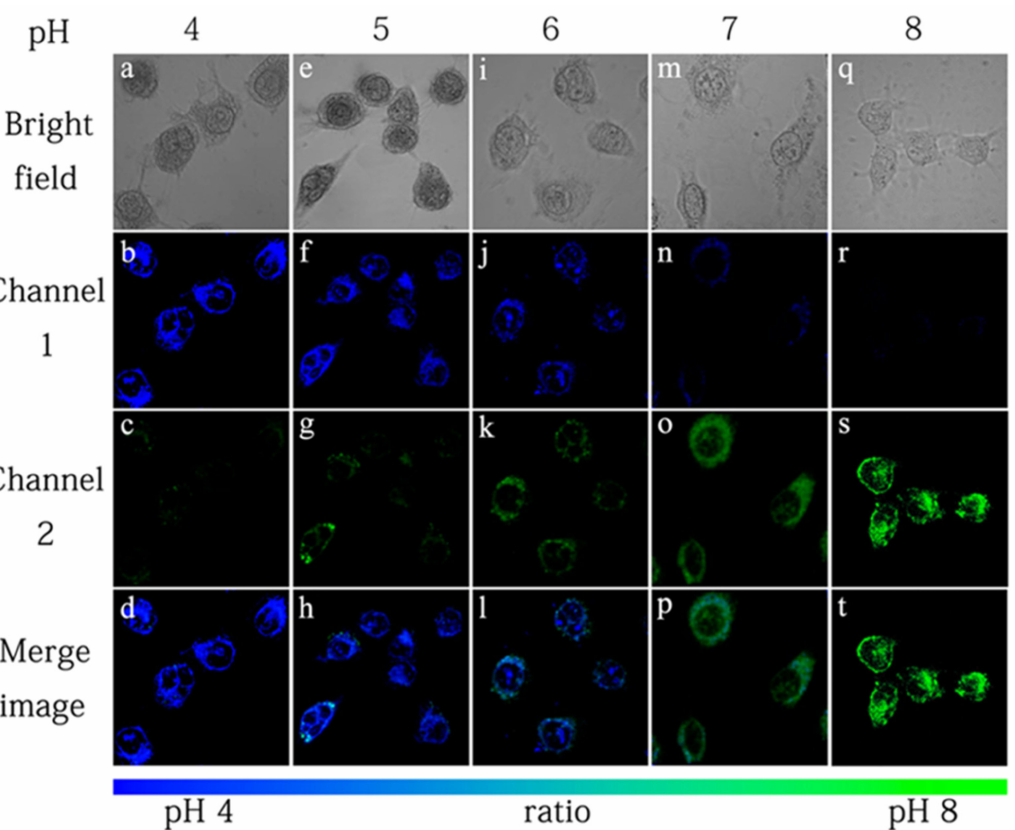
Figure 16. Fluorescence images of probe 6 (10.0 µ M) in HeLa cells with pH 4 ( a – d ), pH 5 ( e – h ), pH 6 ( i – l ), pH 7 ( m – p ) and pH 8 ( q – t ). Channel 1 was collected at 440–480 nm (pyrenyl excimer). Channel 2 was collected at 510–550 nm (fluorescein) [44].